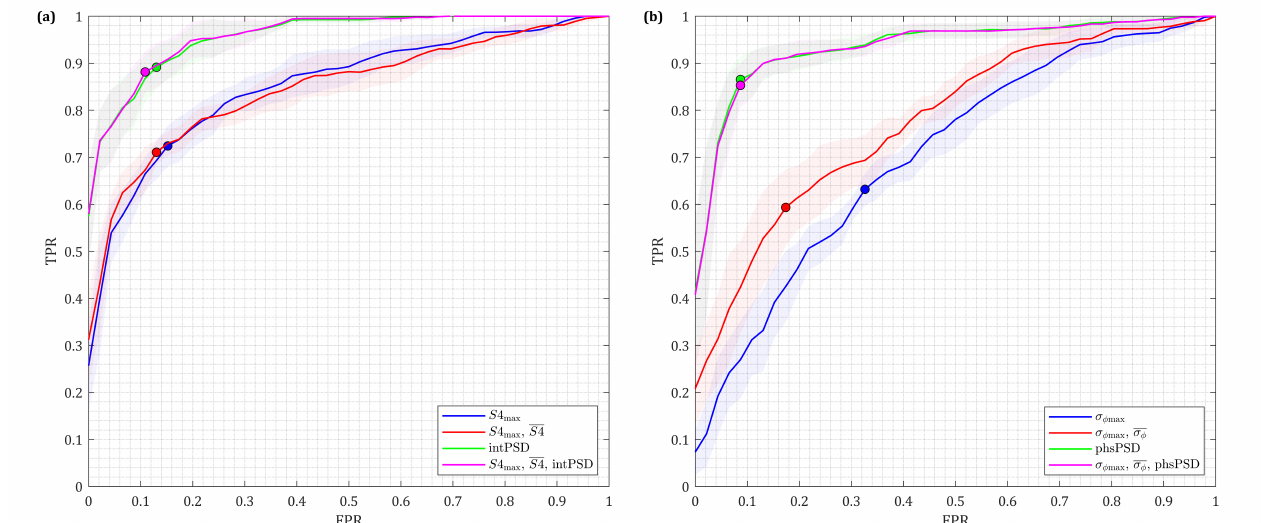
Figure 15. ROC curves obtained with a linear kernel for scenarios assuming ( a ) amplitude and ( b ) phase features. Shaded regions correspond to the 95% confidence